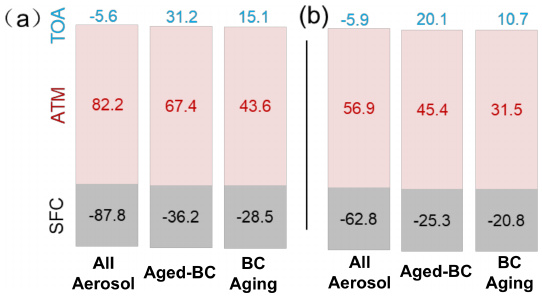
Figure 7. Aerosol direct radiative forcing for total aerosol (left col- umn), aged-BC (middle column), and BC aging (right column) on the top of the atmosphere (TOA), in the atmosphere (ATM), and at the surface (SFC) for 2 severe haze days in Beijing. Panels (a) and (b) correspond to EP1 and EP2, respectively. The forcing caused by BC aging corresponds to the difference in the simulations be- tween the fresh-BC and aged-BC cases. The number denotes radia- tive forcing in the unit of Wm − 2